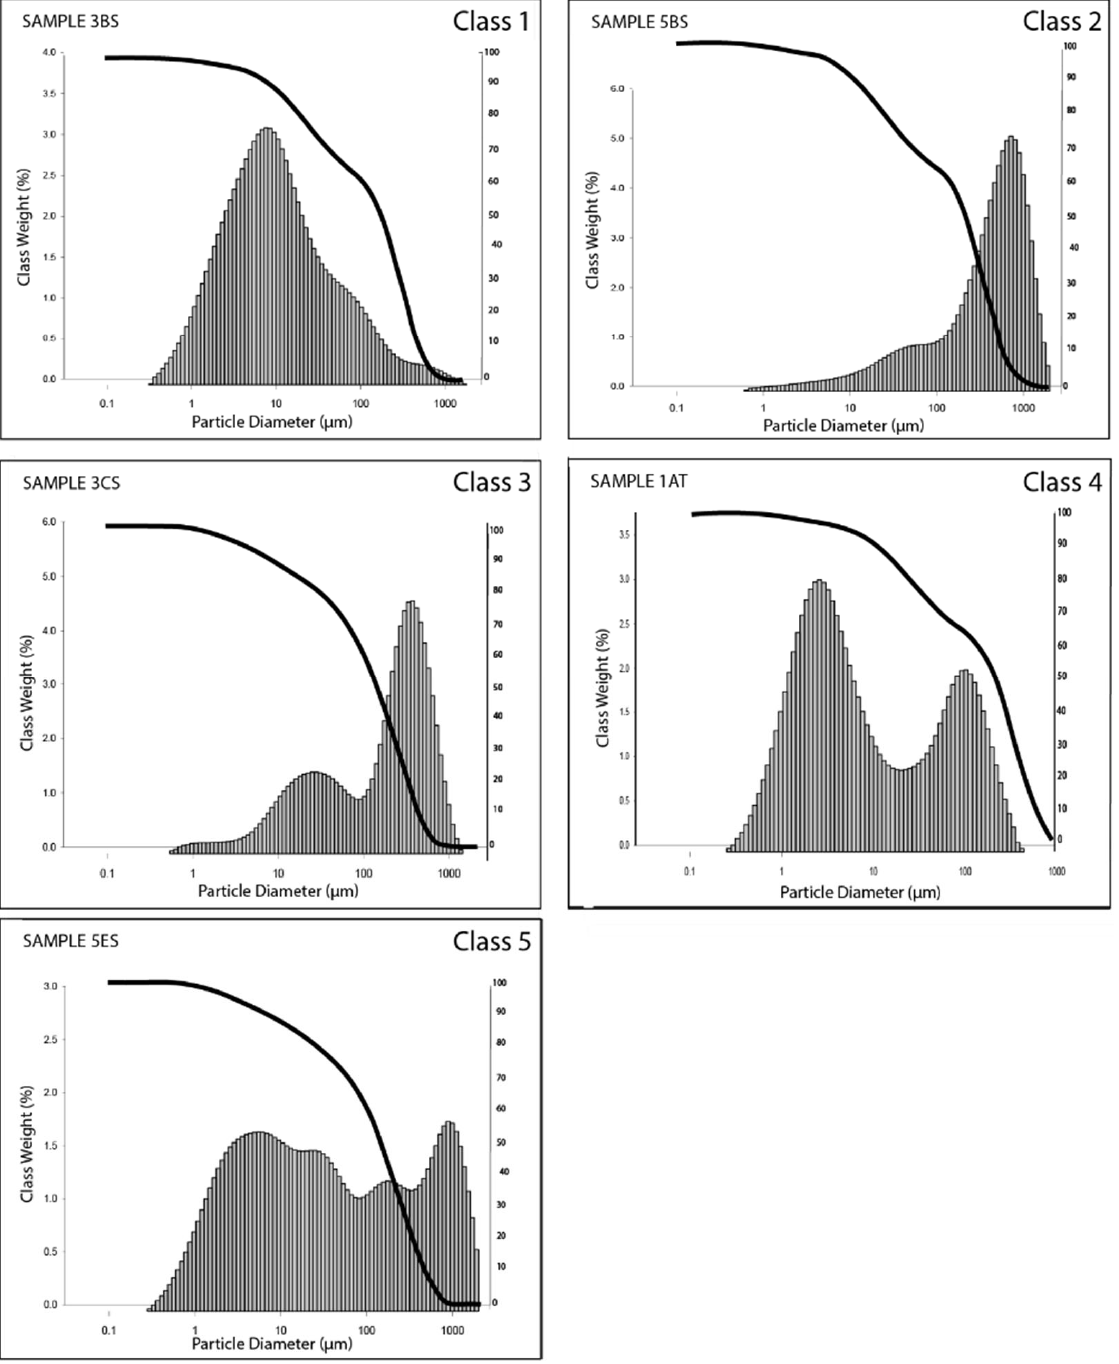
Figure 2. Grain size cumulative curve and frequency histogram of some samples of sediments in Ases cave representative of the five differentiated classes. (1) Sample 3BS: submerged and unimodal sample, Class 1. (2) Sample 5BS: submerged and unimodal sample, Class 2. (3) Sample 3CS: submerged and bimodal sample, Class 3. (4) Sample 1AD: terrestrial and bimodal sample, Class 4. (5) Sample 5ES: submerged and polymodal sample, Class 5.